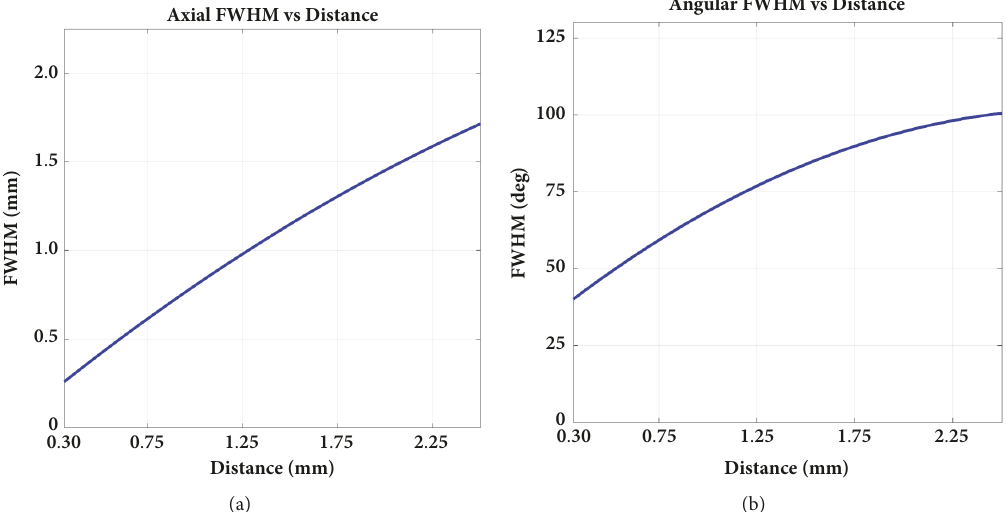
Figure 7: Axial (a) and angular (b) resolutions displayed as a function of distance from the fiber tip. Resolution is measured as the FWHM of a 250 𝜇 m fluorescence